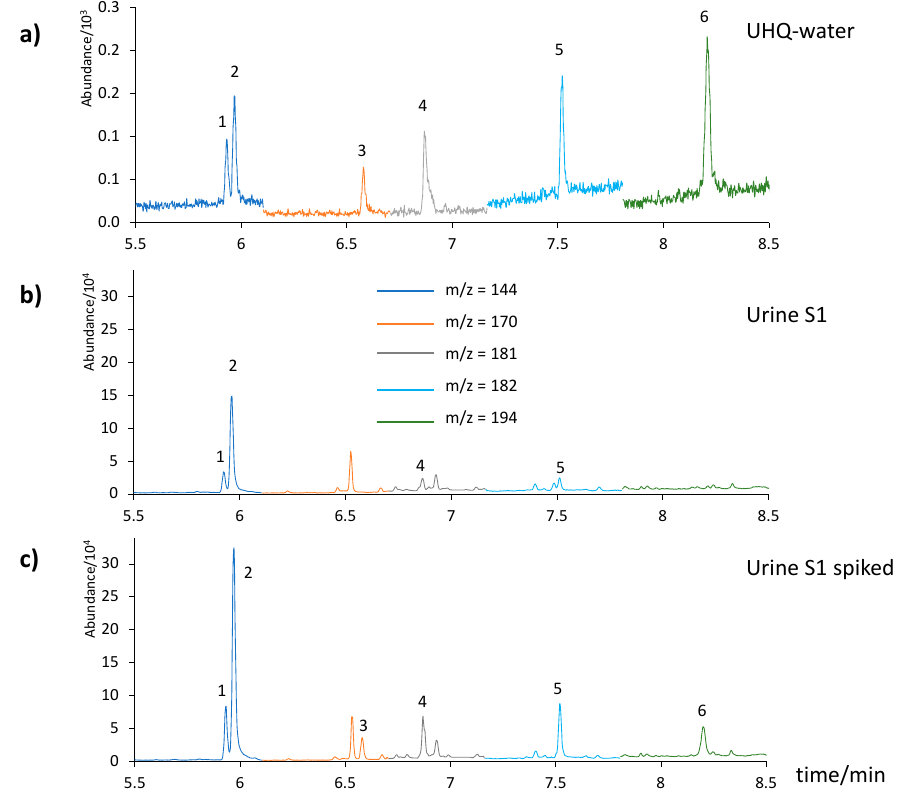
Figure 4. Chromatograms of UHQ-water spiked at the LOQ level in water ( a ), compared to a urine sample analyzed (S1), non-spiked ( b ) and spiked ( c ). 1= 1-NAP, 2 = 2-NAP, 3 = 1-ACE, 4 = 9-FLU, 5 = 2-FLU, 6 = 9-PHE.